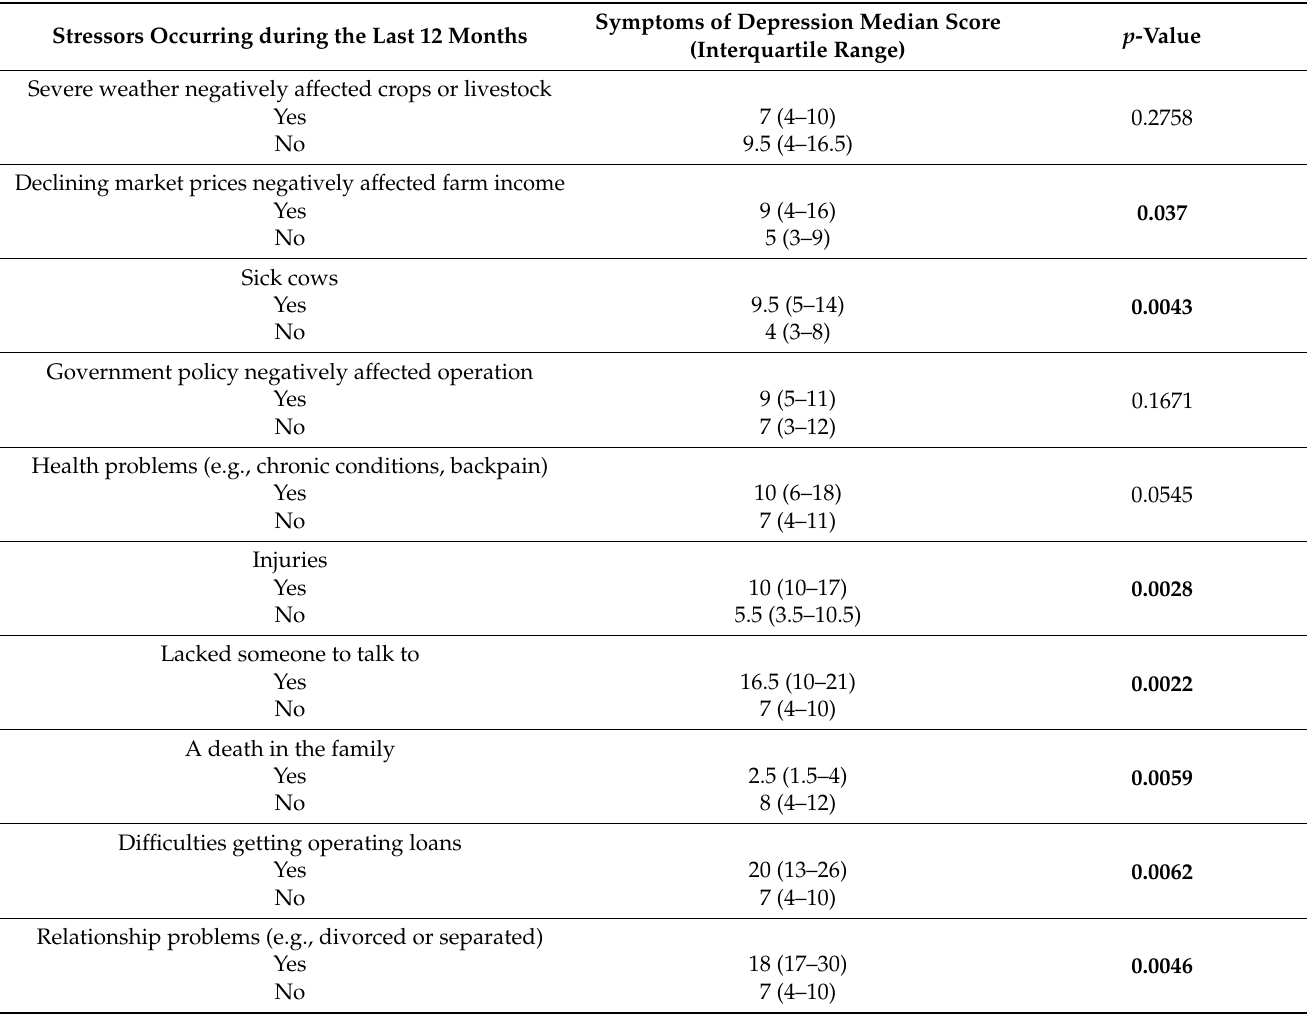
Table 3. Stressors and symptoms of depression scores.